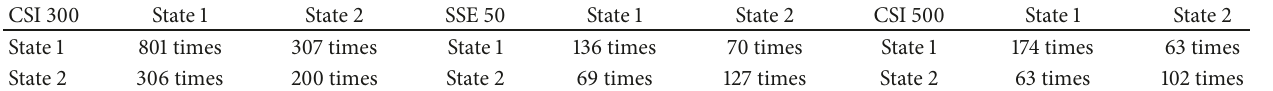
Table 4: The state transition statistics of basis sequences for stock index futures.